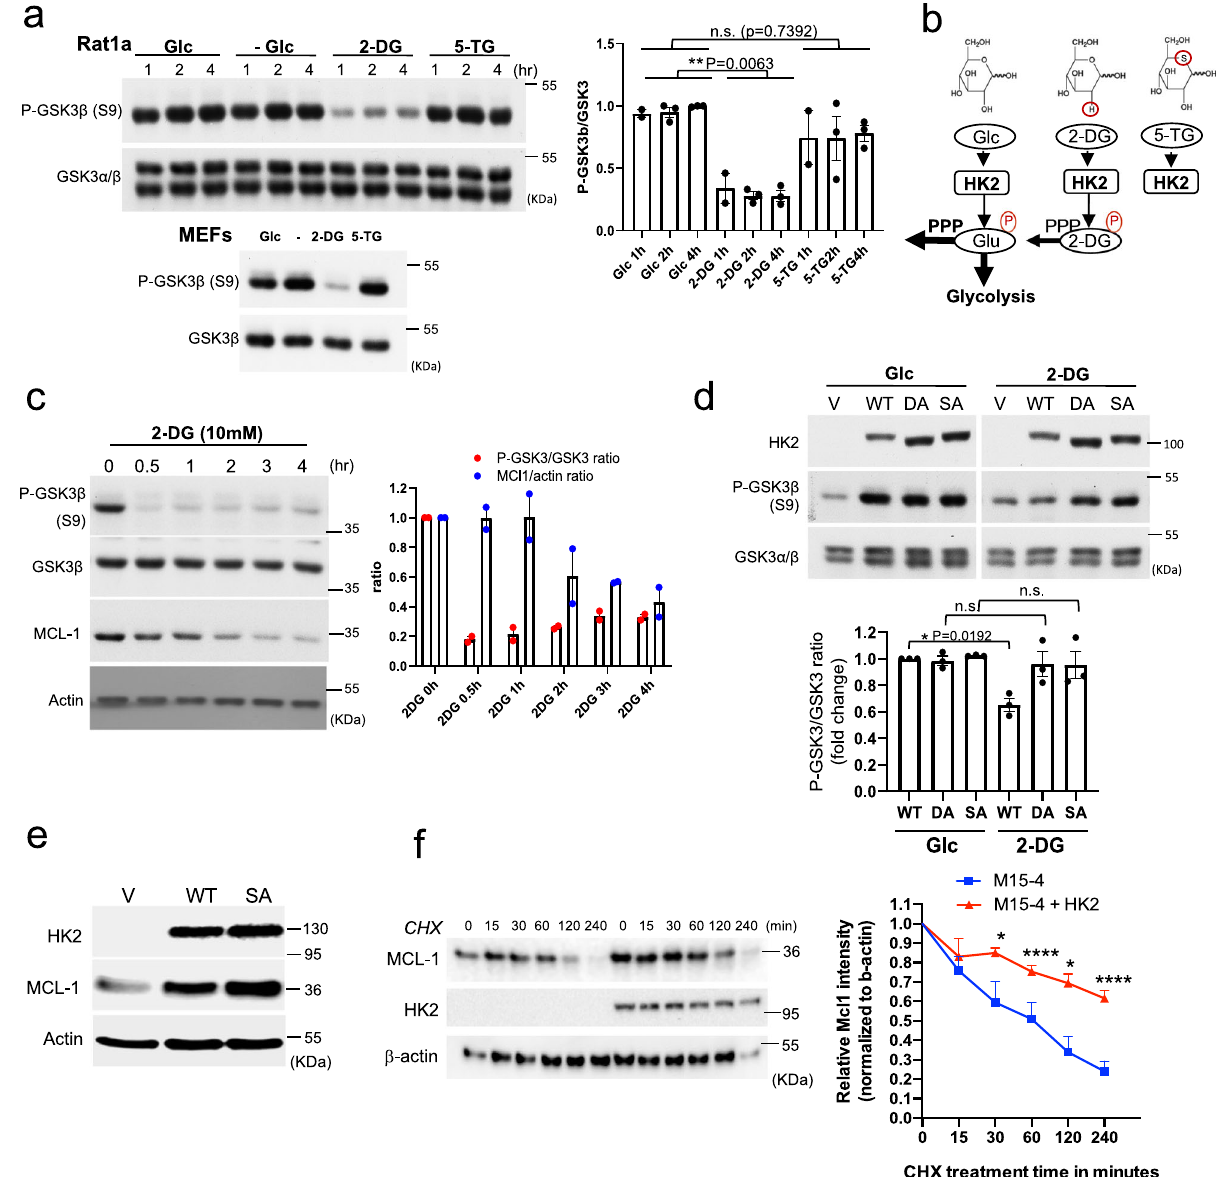
Fig. 1 Replacement of glucose with 2-DG inhibits the phosphorylation of GSK3 and increases GSK3 activity in a HK2-dependent manner. a Rat1a cells or MEFs were incubated in glucose-free medium in the absence ( − ) or presence of 10 mM glucose (Glc), 2-DG or 5-TG. Immunoblots showing GSK3 β phosphorylation, at the indicated time points after incubation. Bar graph shows densitometric quanti fi cation of pGSK3 β /GSK3 α / β ratio from three independent experiments in Rat1a cells ( n = 3). Data are presented as the mean ± SEM. ** p = 0.0063; n.s. p = 0.7392; one-way ANOVA was used to calculate signi fi cance. b Schematic depicting the structures of glucose (Glc), 2-DG, and 5-TG and their utilization by HK inside cells. Like Glc, 2-DG can be phosphorylated by HK2 but cannot be further metabolized except in the fi rst step of the pentose phosphate pathway (PPP). 5-TG cannot be phosphorylated by HK2. c Rat1a cells were incubated in glucose-free medium in the presence of 10 mM 2-DG for the indicated durations. Cells were then harvested for immunoblotting to determine GSK3 β phosphorylation and MCL1 levels. Bar graph shows quanti fi cation from two independent experiments. d MI5-4 CHO cells expressing either wild-type (WT) HK2, individual kinase-dead HK2 mutants (DA, SA) or empty vector (V) were incubated in glucose- free medium in the presence of 10 mM glucose (G) or 2-DG (D). After 2 h, cells were harvested and analyzed for immunoblotting. Bar graph shows relative densitometric quanti fi cation of pGSK3 β /GSK3 α / β ratio (WT, DA, SA). Results are the mean ± SEM of three independent experiments. * p = 0.0192; one- way ANOVA was used to calculate signi fi cance. e Representative immunoblot of three independent experiments showing the level of the MCL-1 protein after expression of WT or kinase-dead SA mutant HK2 in MI5-4 CHO cells. f Protein stability of MCL-1 in MI5-4 CHO cells and MI5-4 CHO cells expressing WT HK2 as measured after exposure to cycloheximide (CHX). Plot showing MCL1 protein half-life after quanti fi cation relative to β -actin. Data are presented as the mean ± SEM. * p < 0.05 ( p = 0.0272 for 30 min and p = 0.0151 for 120 min), **** p < 0.0001 versus 0 h; two-way RM ANOVA test was performed to calculate the signi fi cance ( n = 3 independent experiments). Uncropped blots are provided as a Supplementary Fig. 16. Source data are provided as a Source Data fi le.